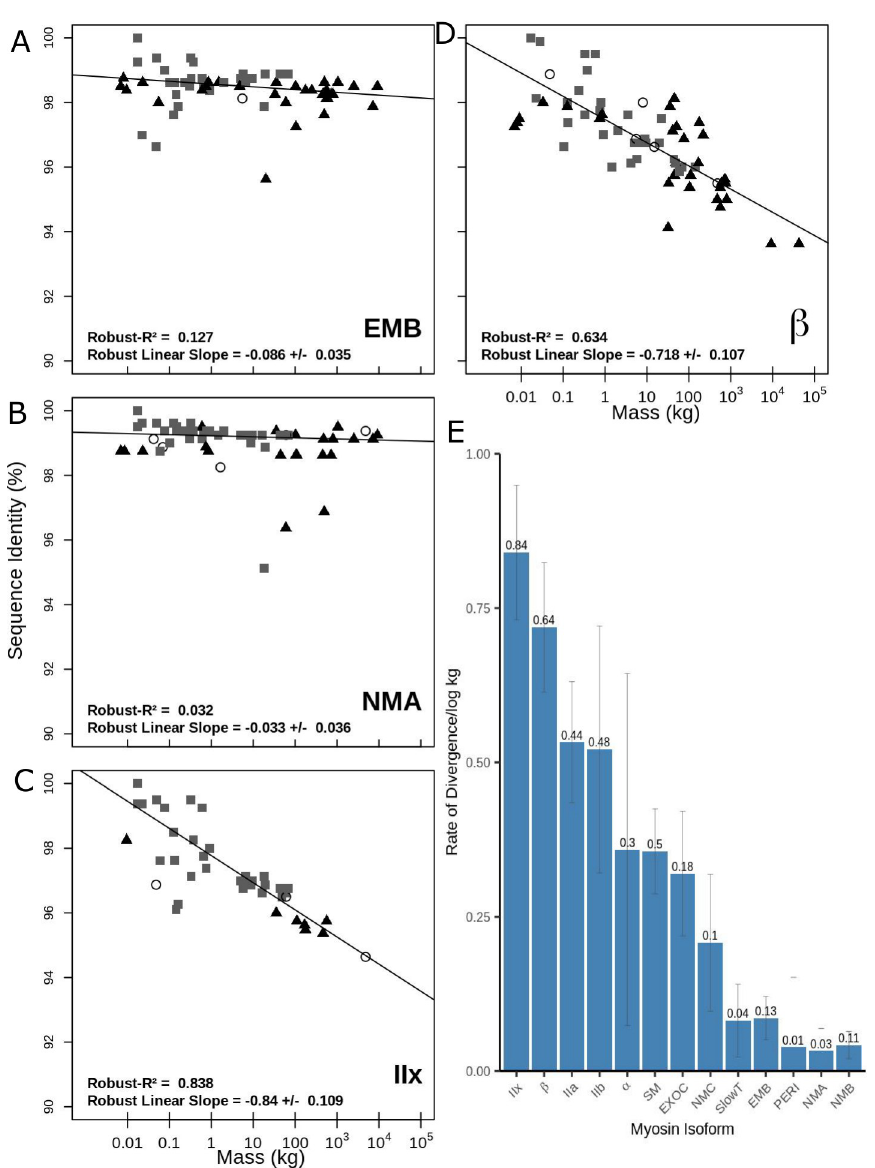
Fig 1. Sequence Identity (%ID) vs. Mass (kg) for myosin II motor domains. (A–D) Sequence Identity (%ID) vs. Mass (kg) for the motor domains of 4 myosin II isoforms: EMB, NMA, β -myosin, and IIx. Symbols indicate the clade that each species belongs to: grey squares (Euarchontoglires), black triangles (Laurasiatheria), and clear circles (Afrotheria and Metatheria). Each plot has been fitted with a robust linear regression. Sequence identity is pairwise to the mouse. The R 2 value and slope are shown on each plot. (E) The relationship between body mass and sequence divergence for the 13 myosin II motor domains. Values above the bar are the R 2 values. The error bars show the error of the gradient. Raw data files are available at Figshare. E AU : AbbreviationlistshavebeencompiledforthoseusedthroughoutFigs 1 and 3 andTable 3 : Pleaseverifythatallentriesarecorrect : MB, embryonic; NMA, non-muscle A; NMB, non-muscle B; NMC, non-muscle C. In Fig 1, the sequence identity versus mass is plotted for 4 representative myosin motor domains: the slow/cardiac β -myosin, the fast muscle IIx, the non-muscle IIa, and the embry- onic isoforms. Plots for the other 9 isoforms are presented in S1 Fig. The plots in Fig 1 show that both adult sarcomeric forms β and IIx have a strong correlation with body mass (R 2 = 0.63